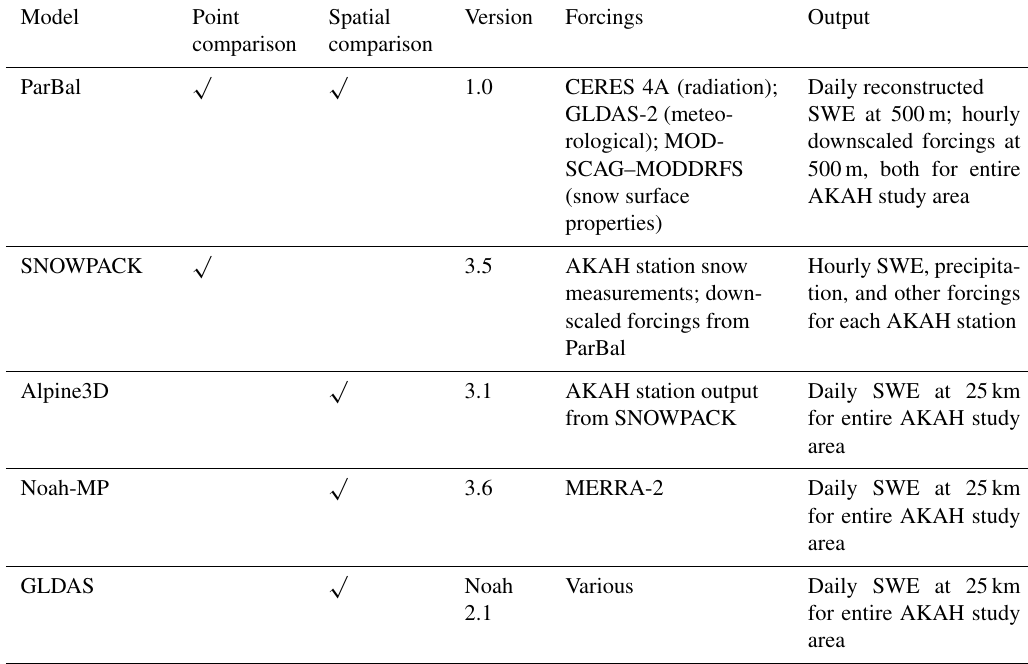
Daily reconstructed SWE at 500m; hourly downscaled forcings at 500m, both for entire AKAH study area Hourly SWE, precipita- tion, and other forcings for each AKAH station Daily SWE at 25km for entire AKAH study area for entire AKAH study area for entire AKAH study